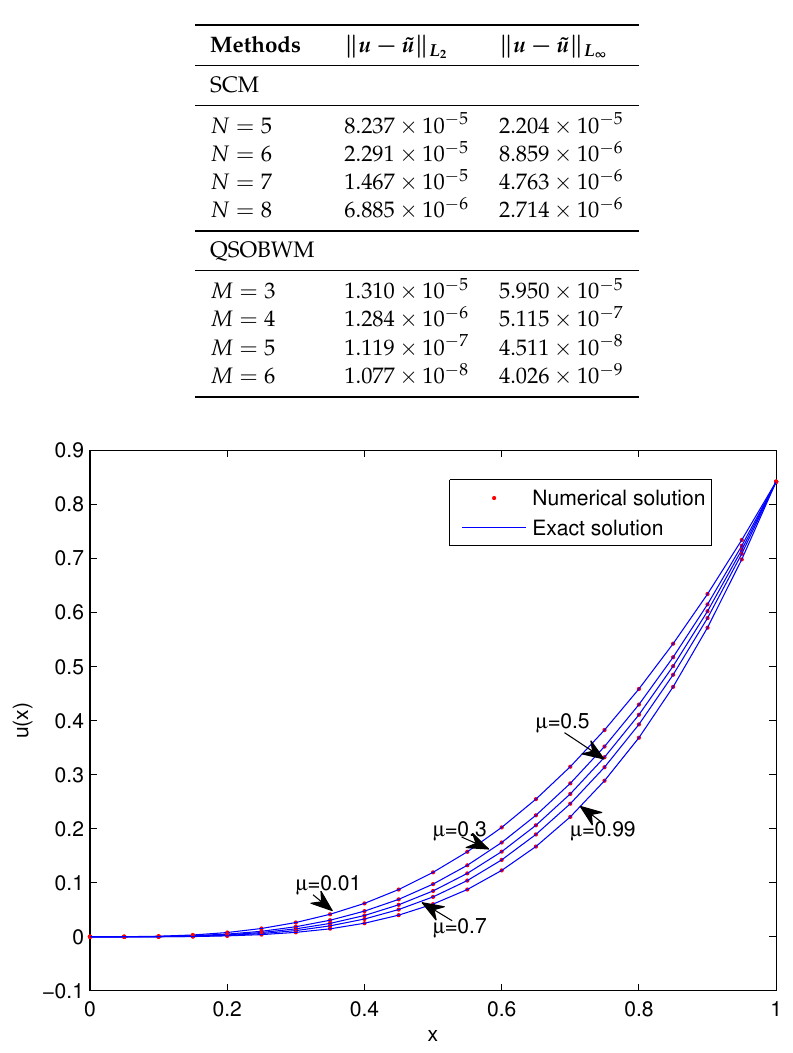
Table 5. Example 3: L 2 errors and L ∞ errors with µ = 0.5 for spectral collocation method (SCM) and QSOBWM.